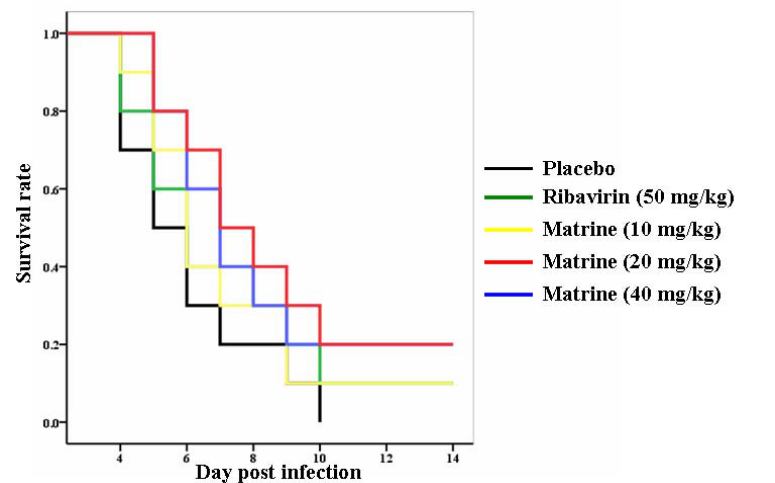
Figure 3. Survival rates of the EV71-infected mice treated with placebo, ribavirin (50 mg/kg) and matrine (10, 20, and 40 mg/kg) were recorded at 14 dpi (n =